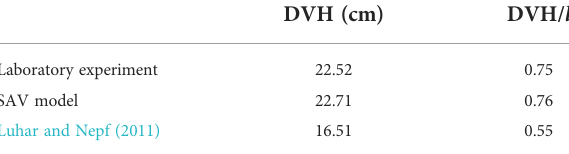
TABLE 3 Comparisons of DVH for one